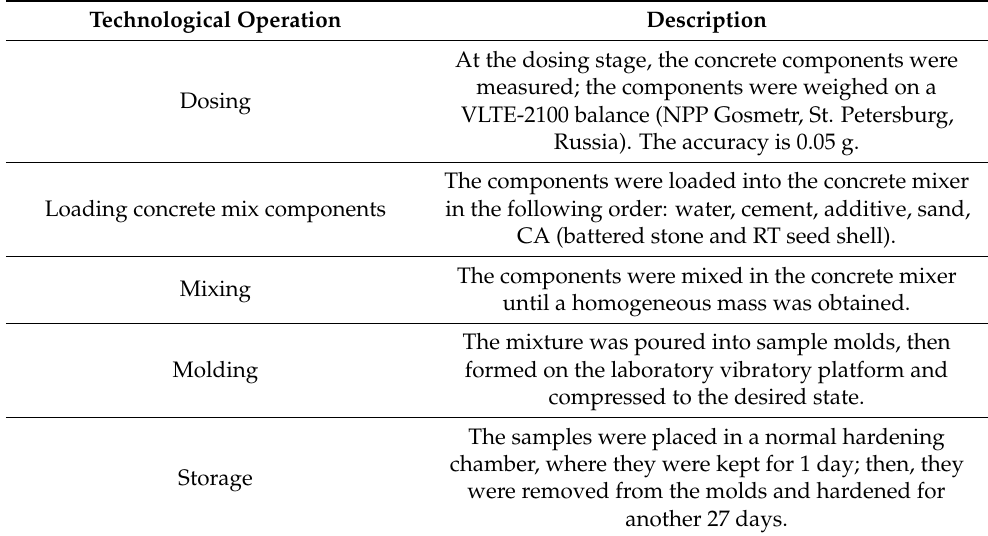
Table 1. Sample preparation procedure.